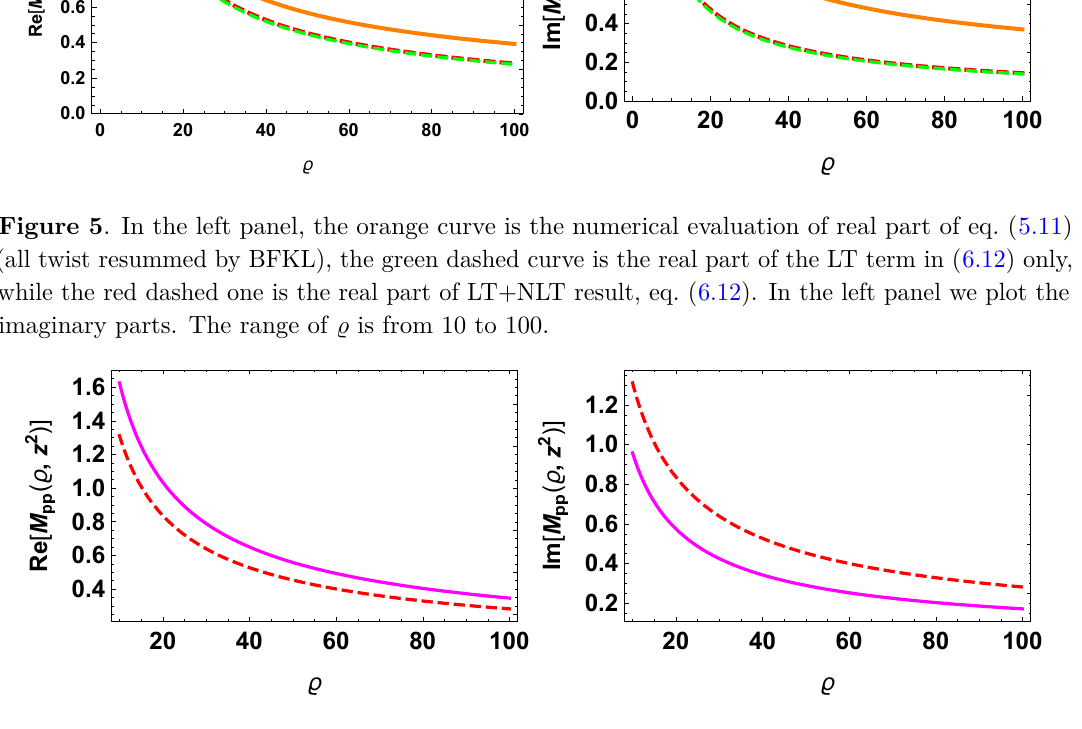
Figure 6 . In the left and right panel we plot the real and imaginary part of eq. (6.12) (red dashed curve), and the real and imaginary part of eq. (6.17) (magenta curve),